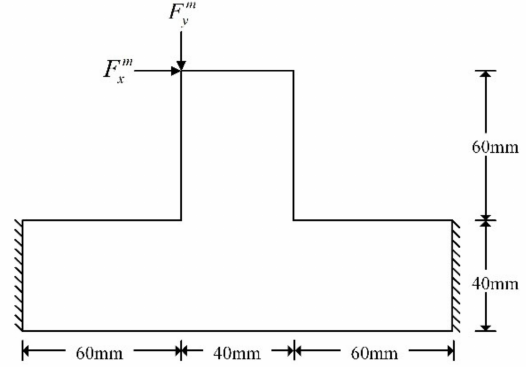
Figure 12. Design domain of T-shaped